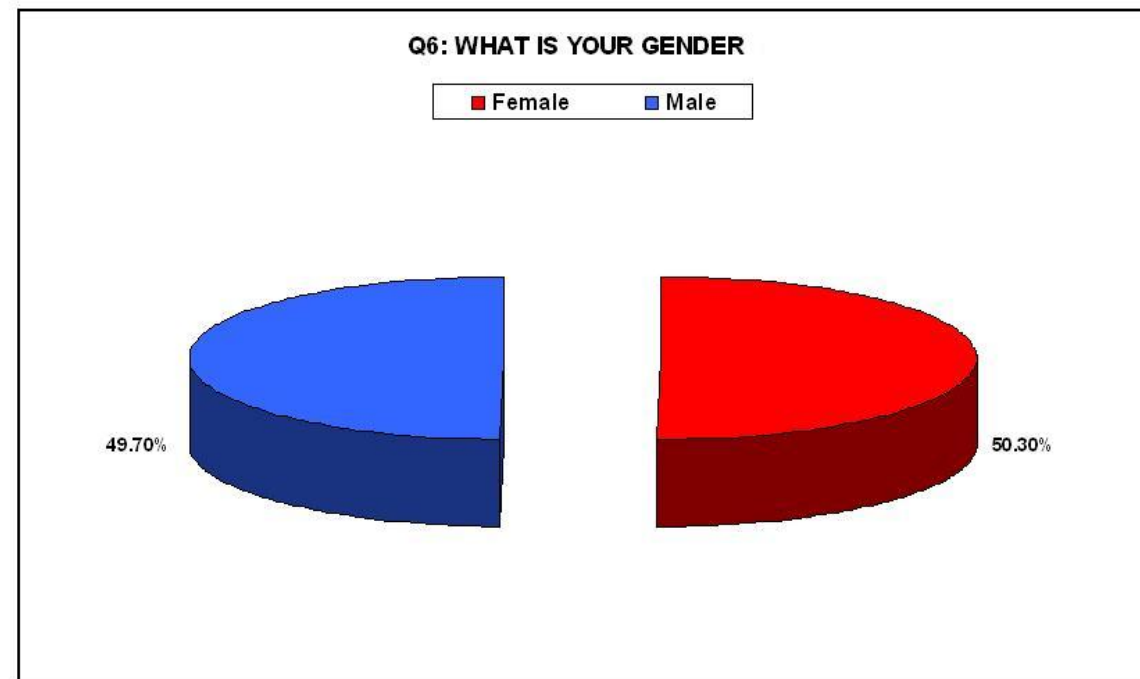
Figure 4 Representation of the responses to Question 6 of the survey